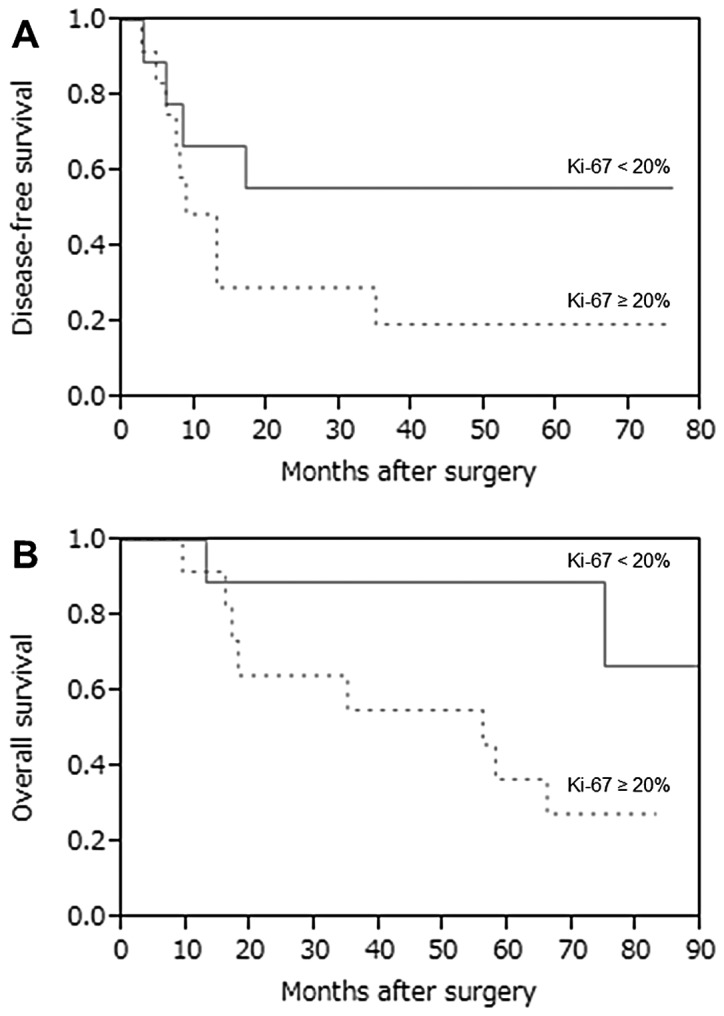
(A) Disease-free (DFS) and (B) overall survival (OS) curves according to the percentage of Ki-67. A high percentage of Ki-67 (≥20%) appears to be as a prognostic factor correlated with OS (P=0.057), while no significant difference between low and high percentages of Ki-67 was observed in the DFS curves (P=0.183).